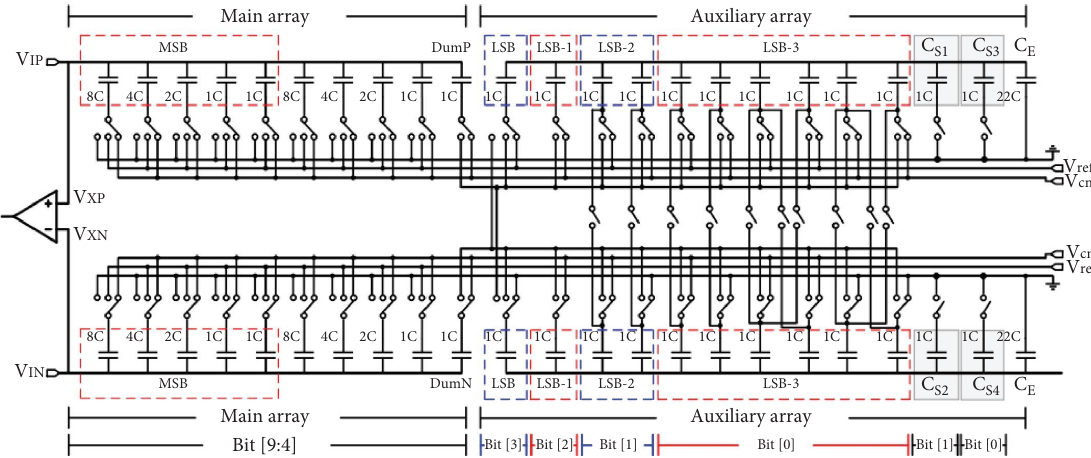
Figure 16: Te charge-sharing switching technique [30].